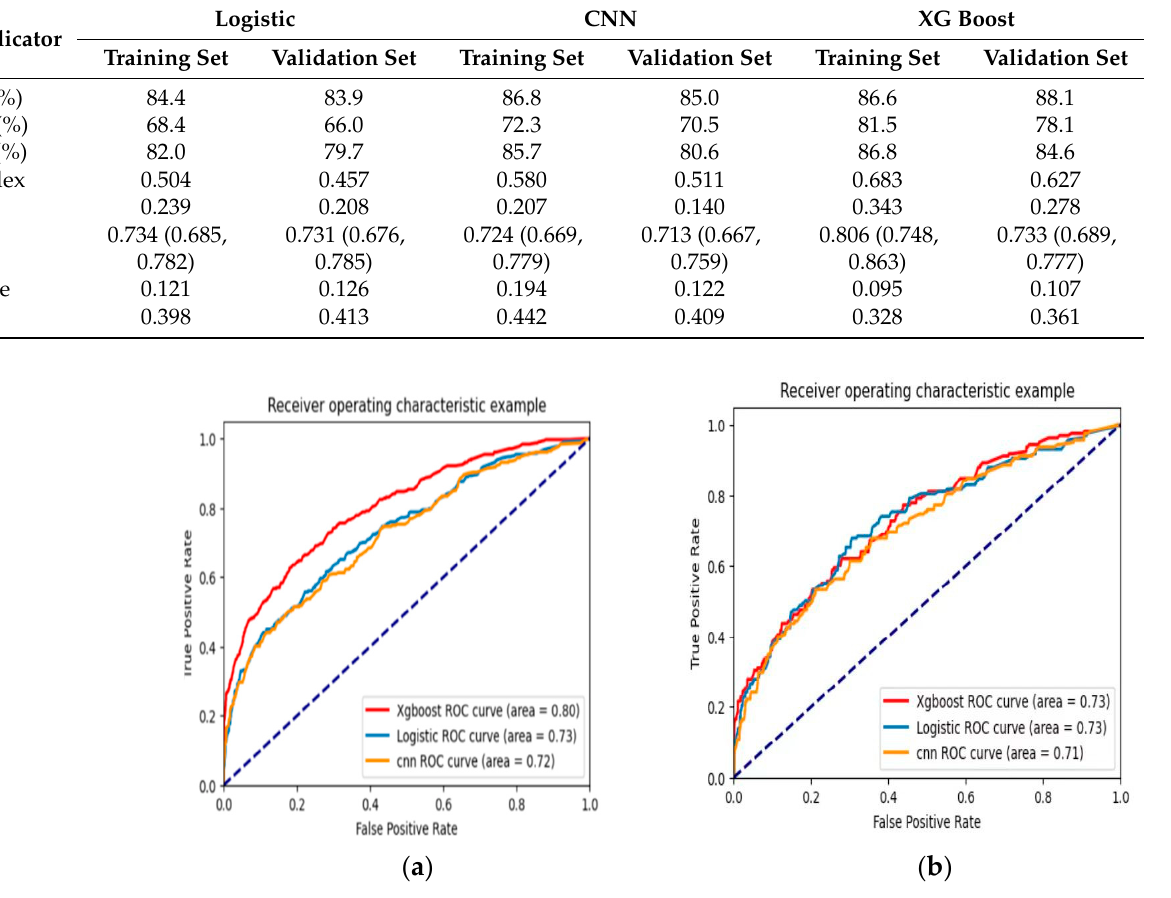
Figure 3. ROC curves of three models. ( a ) Training set; ( b ) validation set.